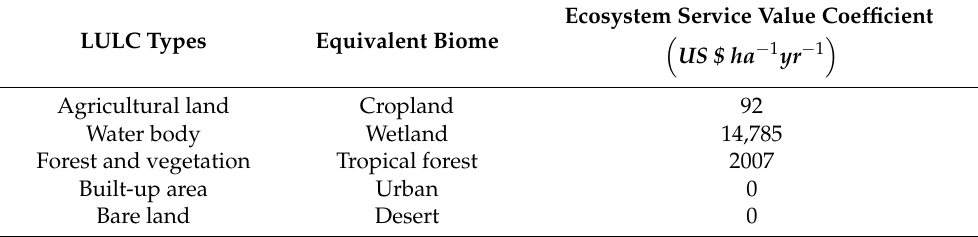
Table 3. Biome equivalents for the five land-use categories and the corresponding ecosystem values